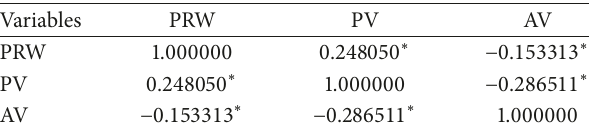
Table 5: Correlation analysis (Spearman’s 푟 ) between PRW, PV, and AV for the first period